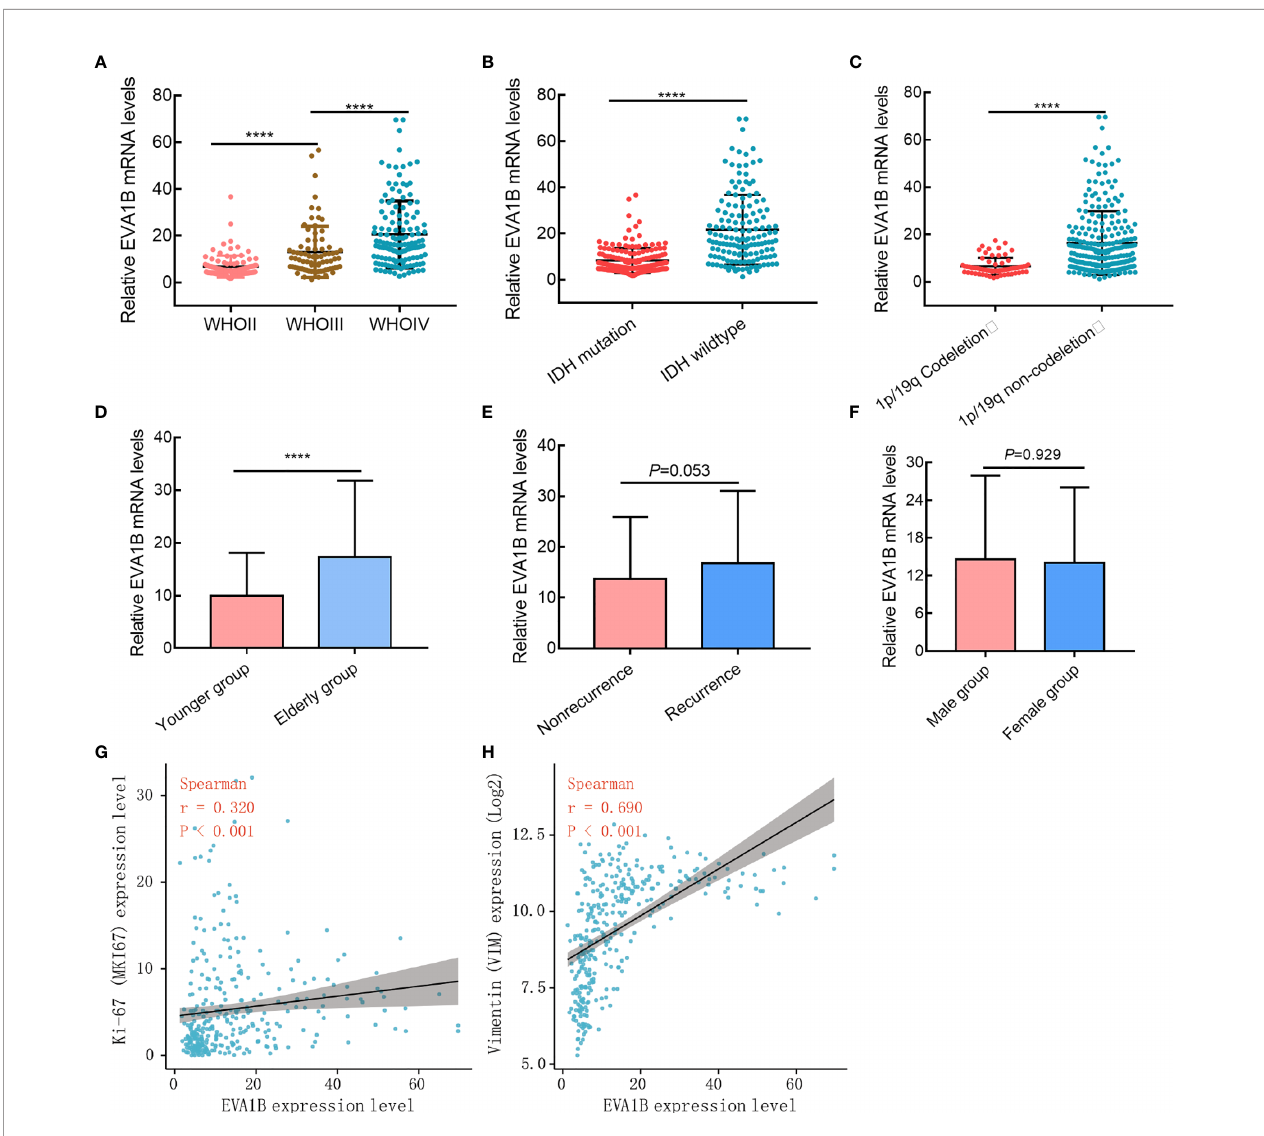
FIGURE 2 | The association between EVA1B expression and clinicopathological features in glioma cohort (CGGA cohort, n = 325). (A – F) The EVA1B expression was signi fi cantly associated with WHO grade, IDH wildtype, 1P/19q non-codeletion, and age, but not with recurrence of glioma and sex. (G, H) EVA1B expression was weakly associated with proliferation marker (Ki-67 expression), and strongly associated with invasion marker (Vimentin expression). (****P <